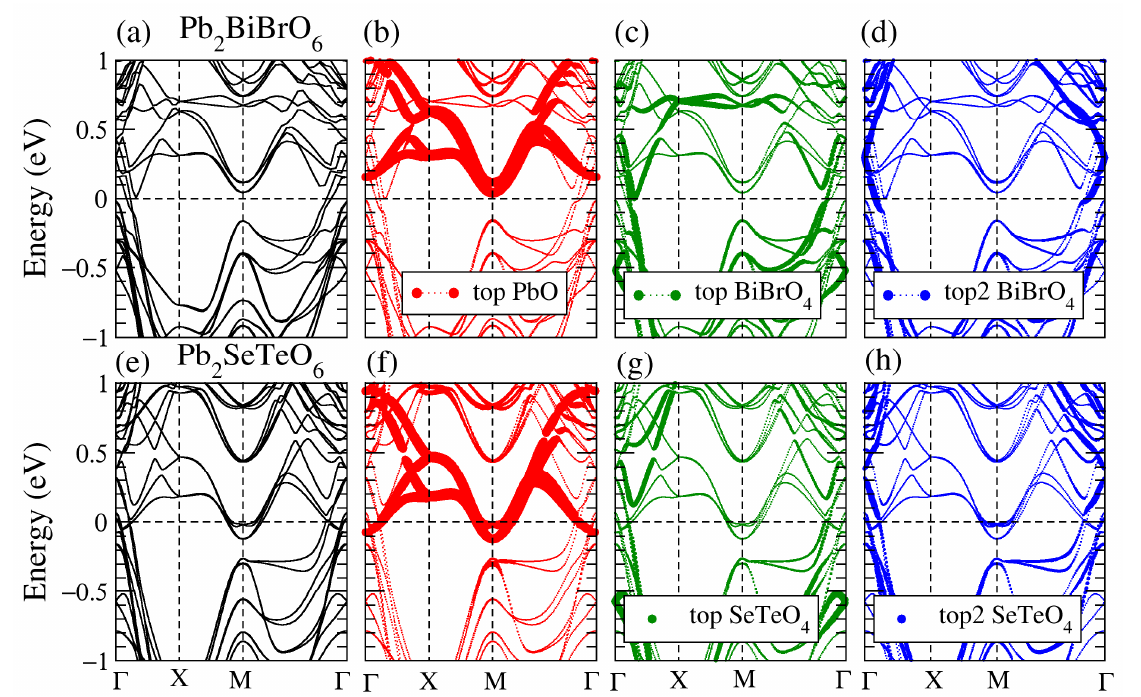
Figure 6. Surface electronic band structure of the Pb 2 BiBrO 6 and Pb 2 SeTeO 6 supercell, ( a , e ) total band structures, ( b – d ) project band structures of the top PbO, BiBrO 4 and top2 BiBrO 4 layer, ( f – h ) project band structures of the top PbO, SeTeO 4 and top2 SeTeO 4 layer, respectively. Note that only the Pb, Bi/Se, and Br/Te atoms’ orbitals are projected. The Fermi energy is set to be zero as a reference.